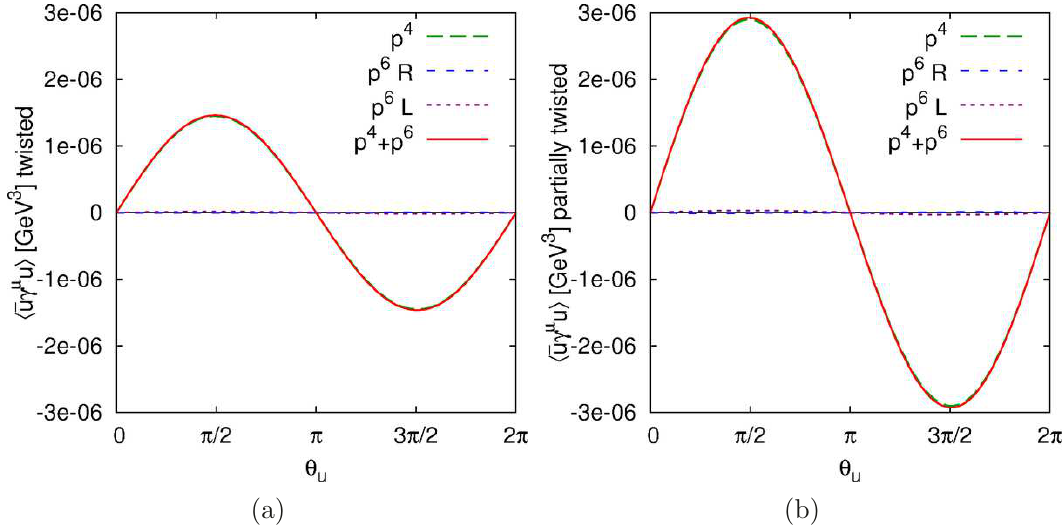
¯ uγ µ u with the up valence and sea quark twisted with h i